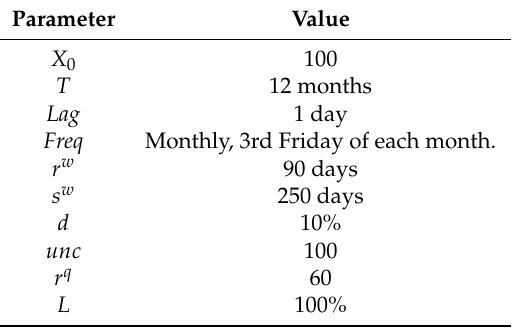
Table 12. Parameters used in the implementation of the BL and NL factor rotation strategies as defined in the workflow.